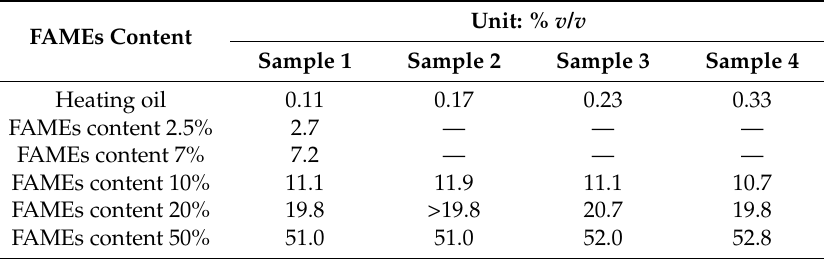
Table 5. Fatty acid methyl esters (FAMEs) content.